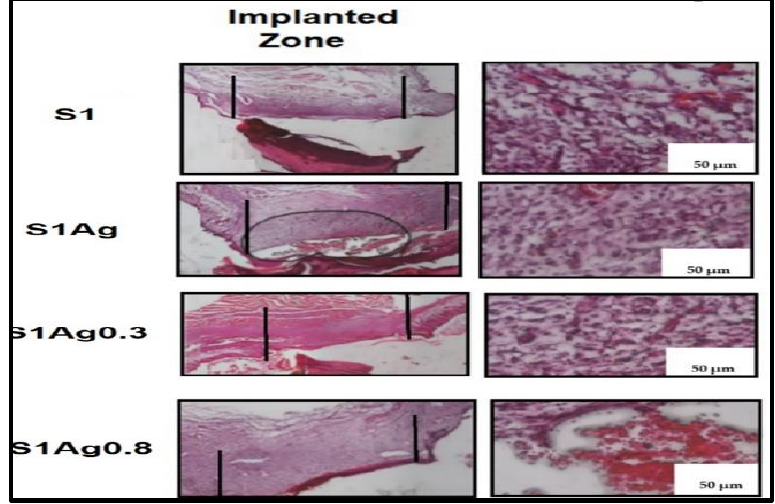
Figure 8. H&E staining images of full defected area of the skin wound treated (implanted zone) in the four samples after 15 days.